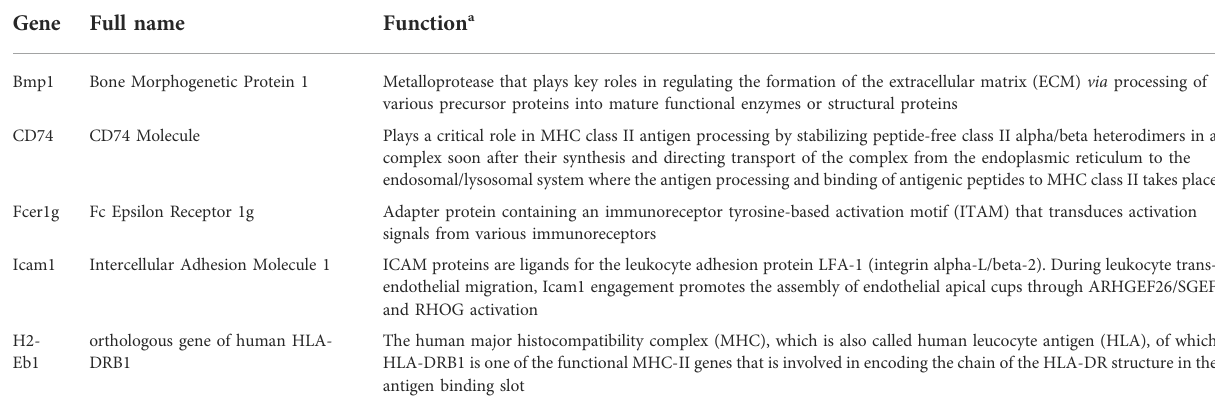
TABLE 2 The functions of fi ve hub